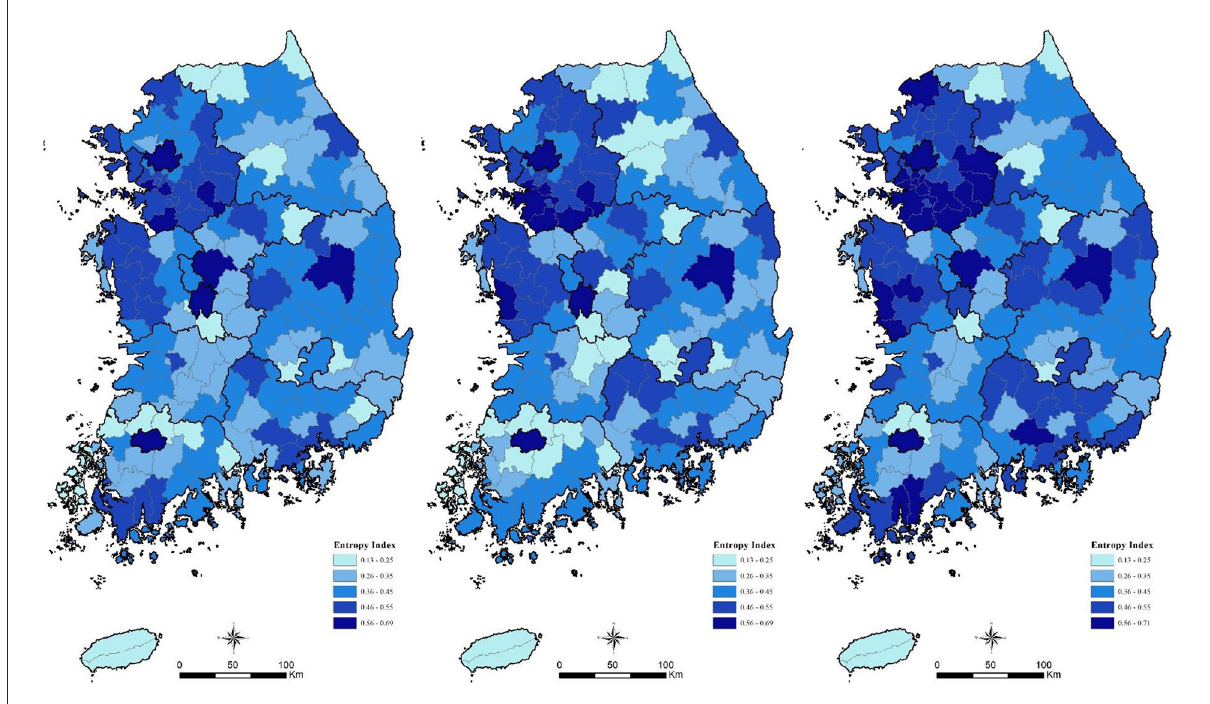
FIGURE5 Distribution of entropy index (2000, 2010,